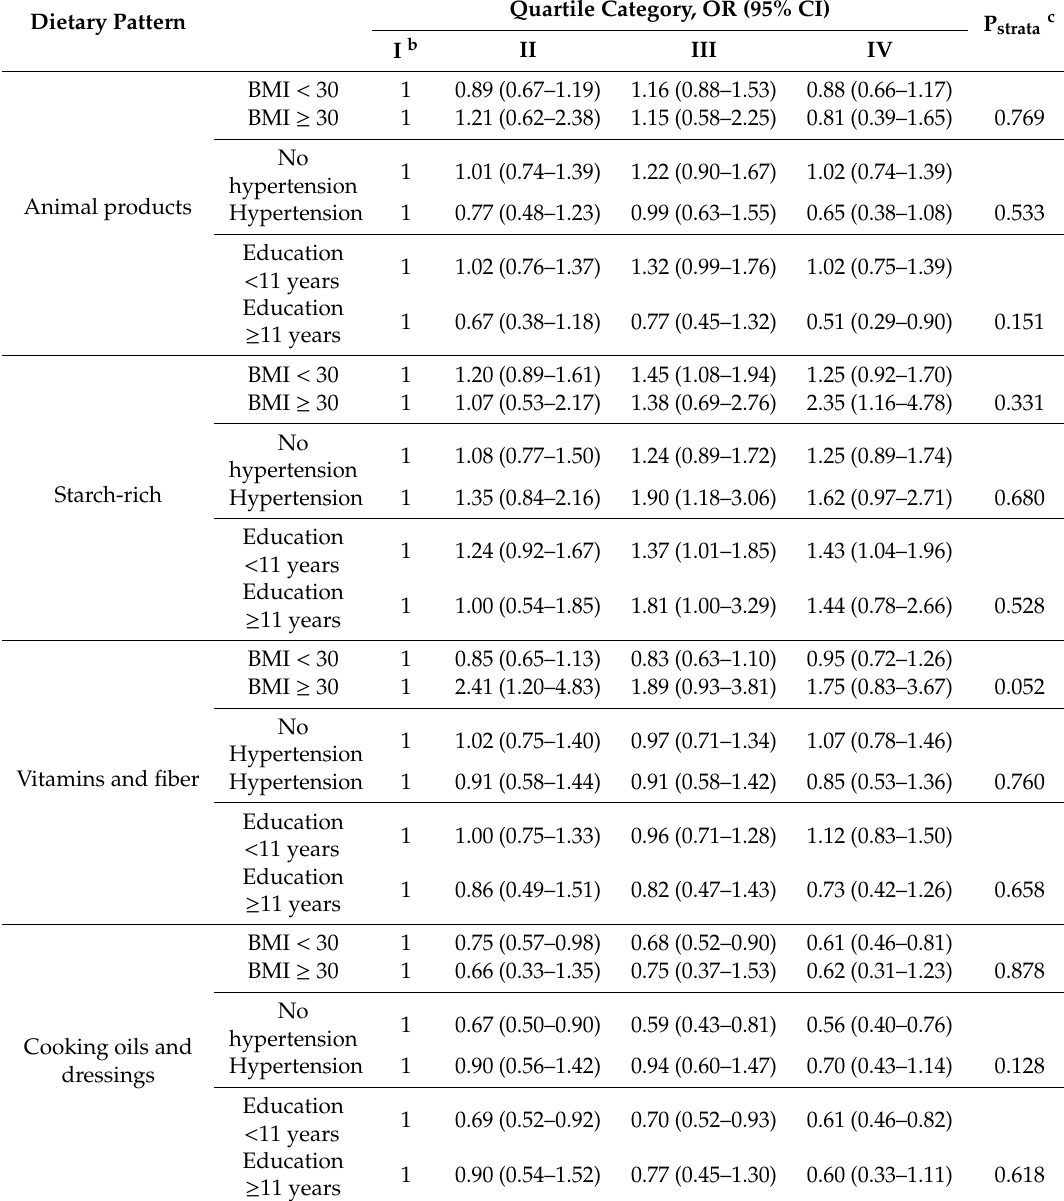
Table 6. Odds ratios (ORs) a of renal cell carcinoma and corresponding 95% confidence intervals (CIs) on quartiles of factor scores in strata of body mass index (BMI), hypertension, and education. Dietary Pattern